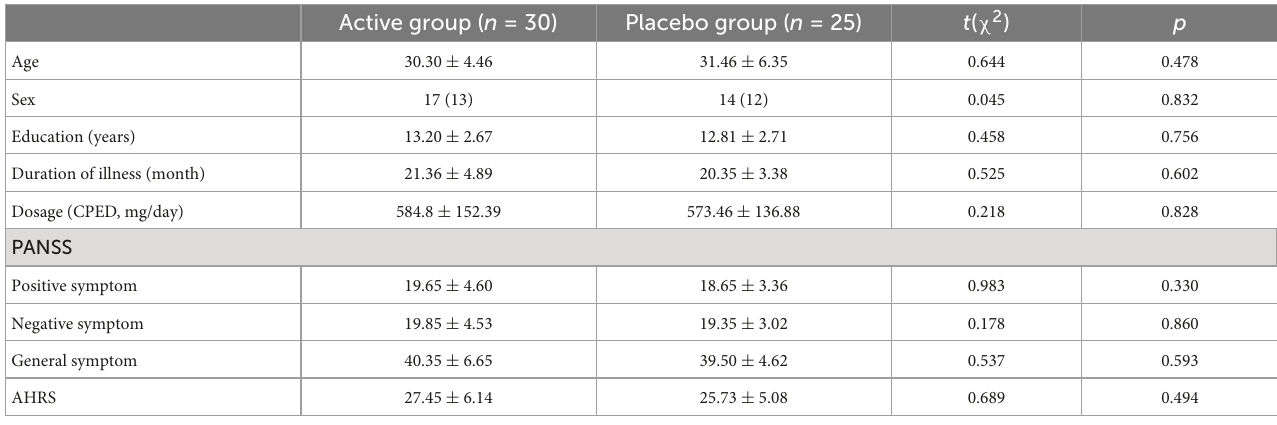
TABLE 1 Demographic and clinical characteristics of the two patient groups receiving either rTMS or placebo treatment.